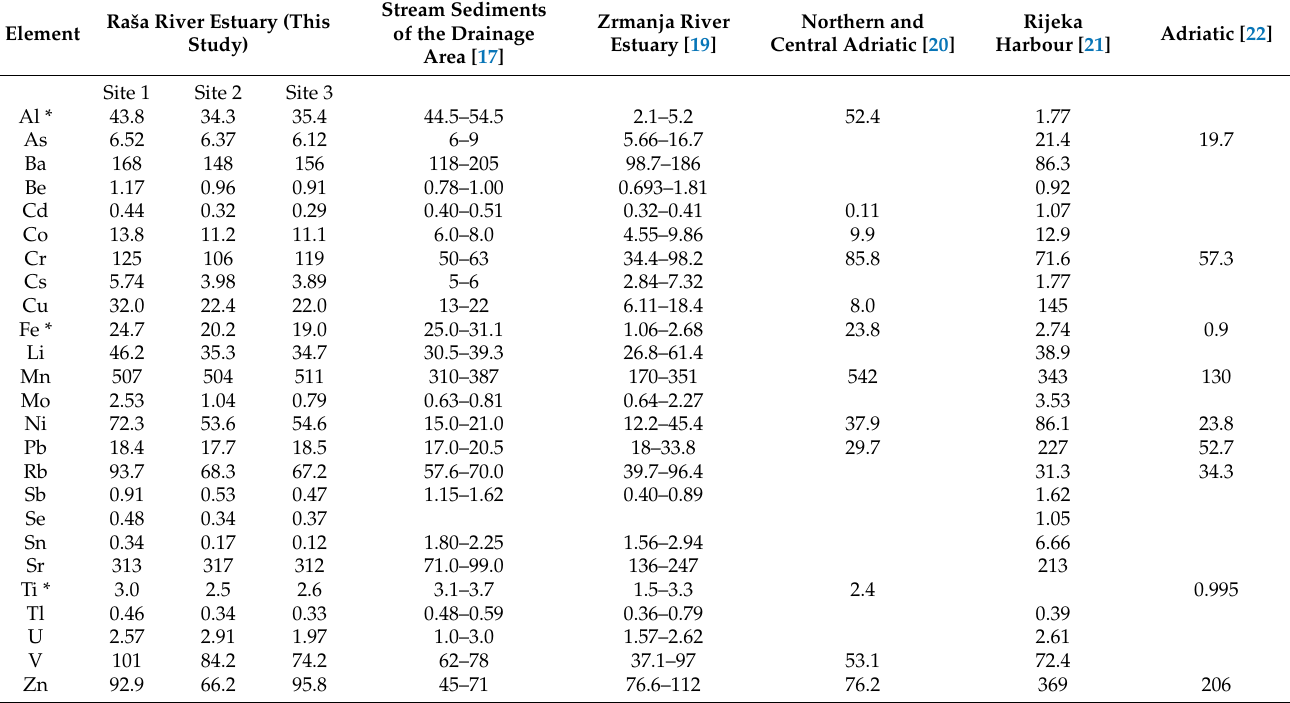
Table 3. Comparison of element concentrations in sediments of the Raša River estuary with literature values, expressed in mg kg − 1 or * g kg − 1